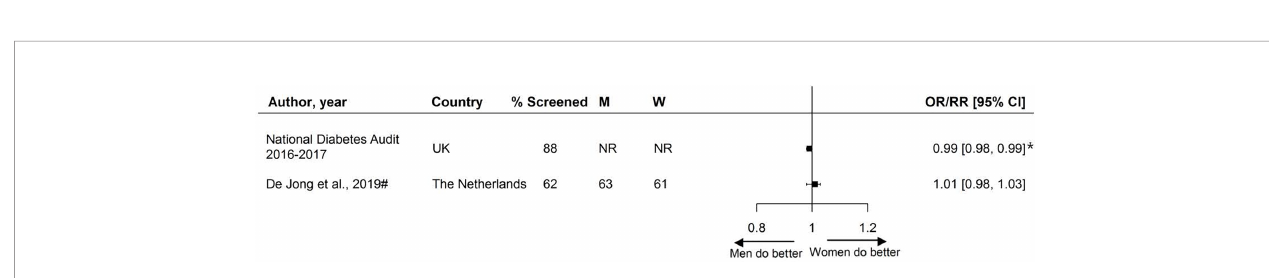
FIGURE 4 | Assessment of lipids, expressed as adjusted odds ratios (OR) or relative risks (RR) with corresponding 95% con fi dence intervals (CI). One study is not presented in this fi gure because of the measure of association: Swietek et al. (33): Average Marginal Effect (LDL), (SE; p-value): 0.0045 ( − 0.0042; >0.05). W = % of screened women; M = % of screened men; US, United States; UK, United Kingdom; # = Relative risk; ^ = Kaplan-Meyer estimates; * = statistically signi fi cant. Men = reference.